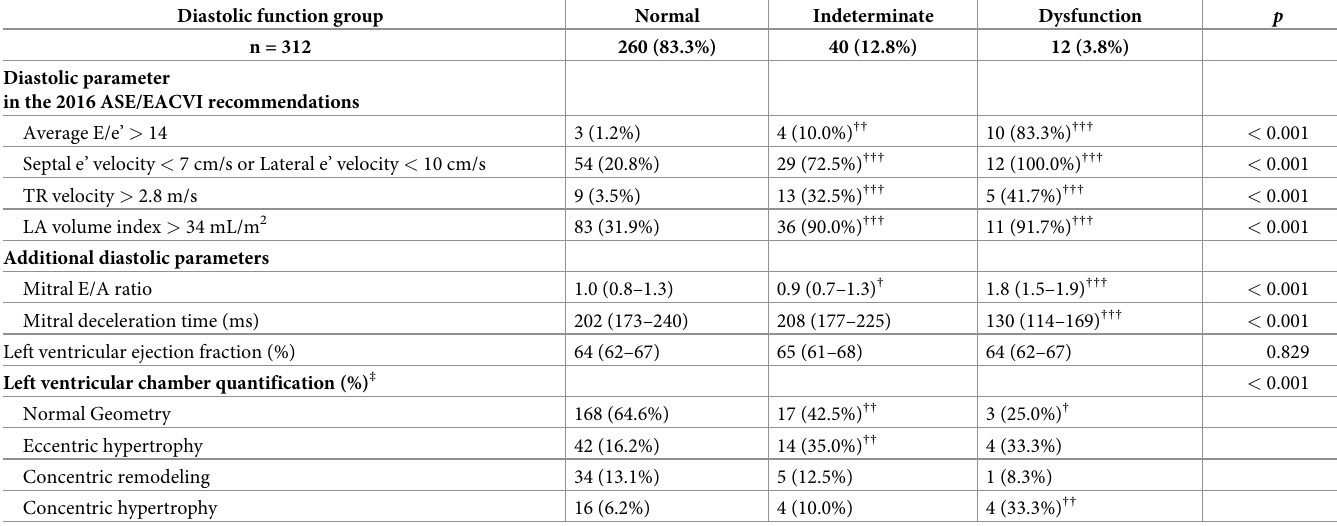
Table 2. Comparison of preoperative transthoracic echocardiographic characteristics according to diastolic function in the 2016 ASE/EACVI recommendations in patients undergoing living-donor liver transplantation. Diastolic function group